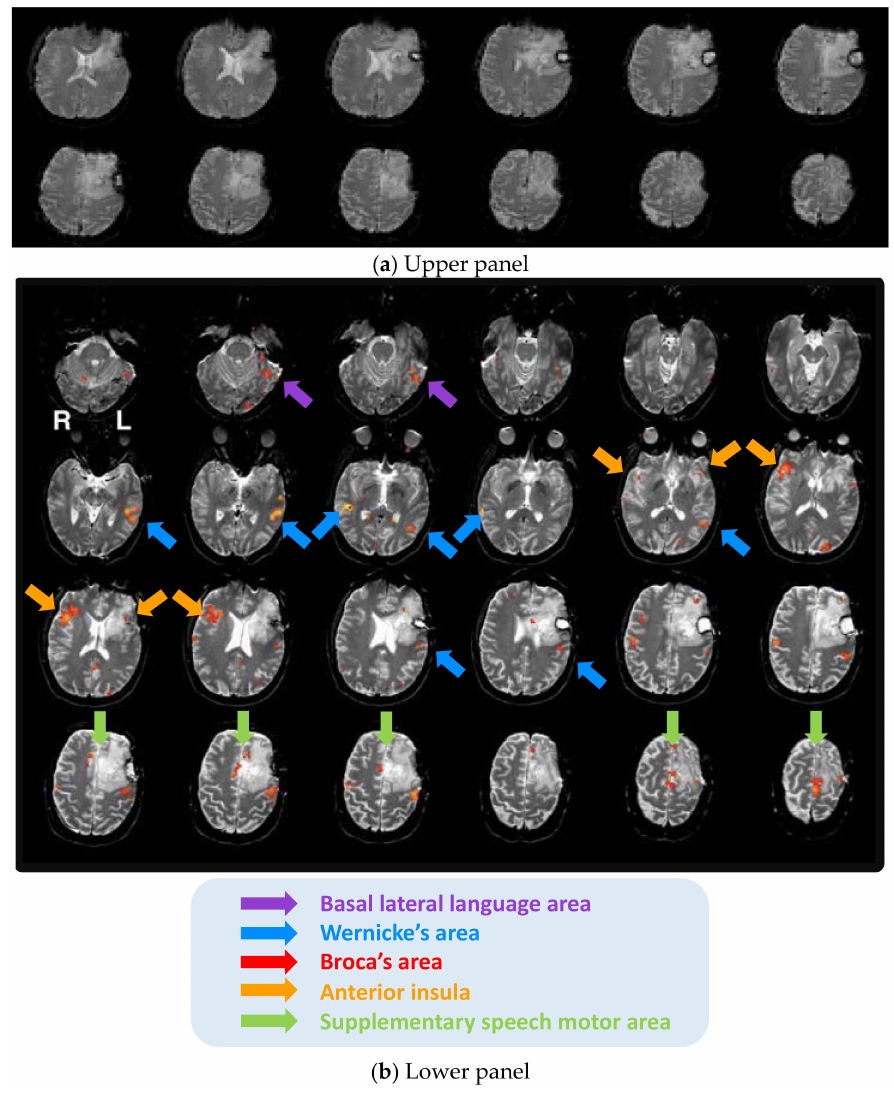
Figure 1. Disrupted fMRI language dominance in Case 1. ( a ) Upper panel: signal loss in and around the lesion from prior resection. ( b ) Lower panel: the lack of functional activity associated with Broca’s area can be